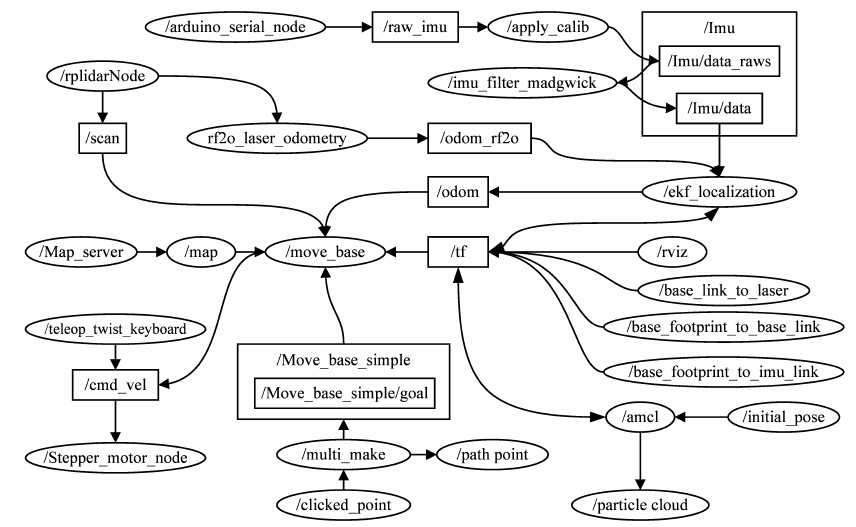
Figure 6. ROS topics and nodes associated with